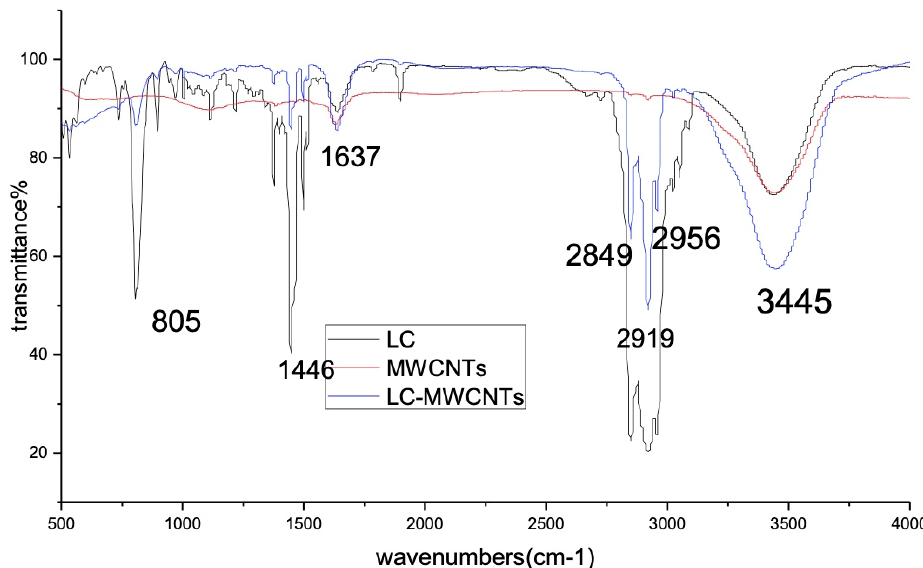
Figure 1. The infrared spectrometric results of MWCNTs, LC and MWCNTs-LC.